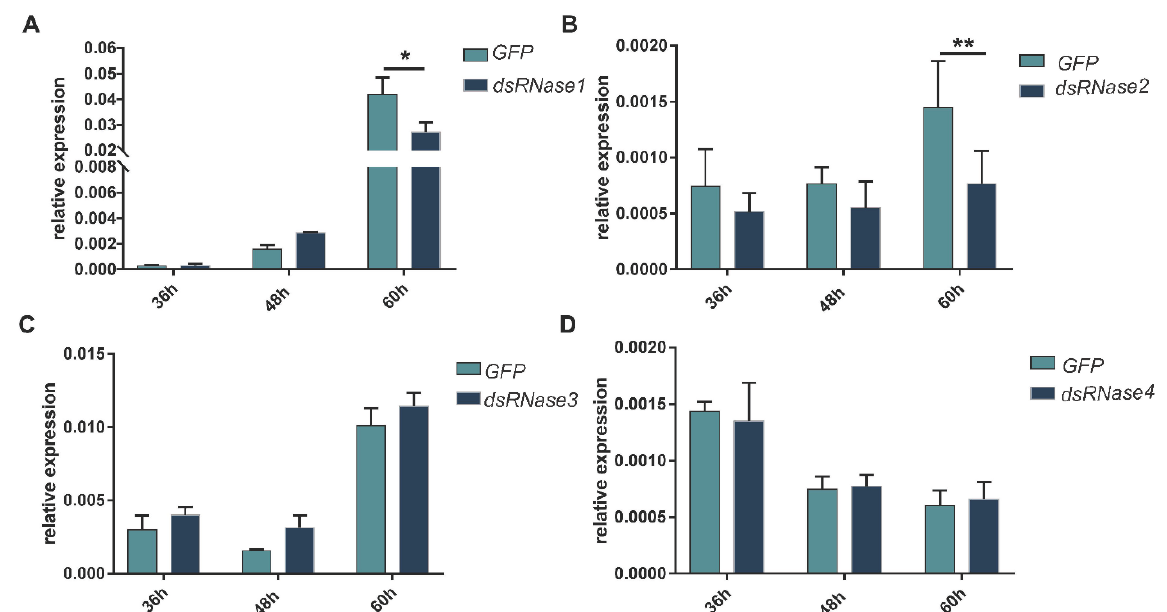
Figure 6. Effects of uptake dsRNA on relative expression levels of PxdsRNase genes in the larvae. Three μg of dsPxdsRNase (dsPxdsRNase1, dsPxdsRNase2, dsPxdsRNase3 or dsPxdsRNase4) or dsGFP were fed to the fourth instar larvae, and the transcription levels of PxdsRNase genes were measured by RT-qPCR. EF1 was used as the reference gene for normalization. Statistical analyses were performed using one-way ANOVA followed by the Turkey test. ( A ) PxdsRNase1 ; ( B ) PxdsRNase2 ; ( C ) PxdsRNase3 ; ( D ) PxdsRNase4 . (*, p < 0.05; **, p < 0.01).